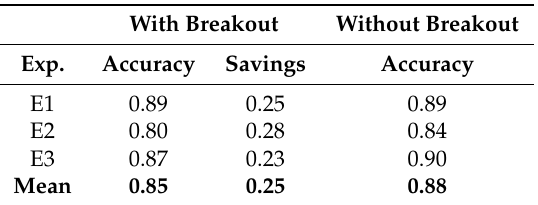
Table 13. Summary of the evaluation results with and without breakout detection.